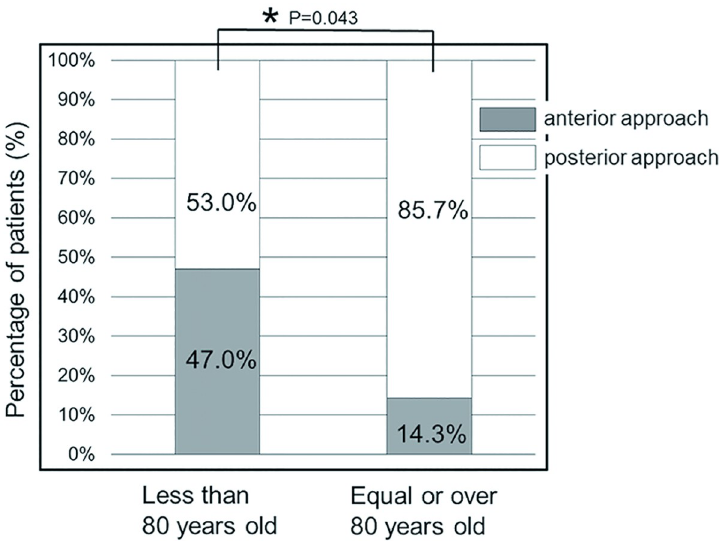
Fig 4. Bar graph showing the proportion of patients in the study treated using anterior and posterior surgical approaches.